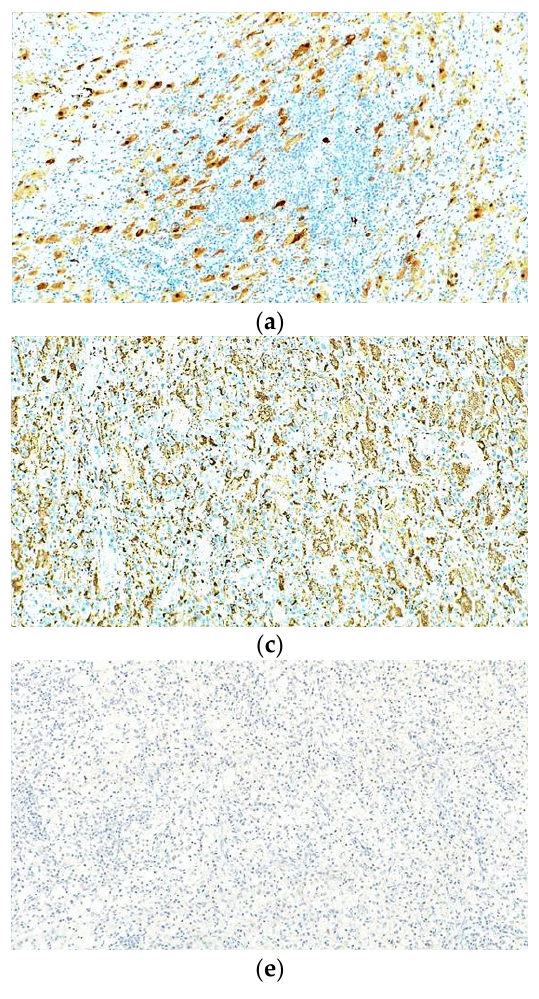
Figure 9. Rosai – Dorfman disease of the bone. Immunohistochemical positive reactions for ( a ) S100; ( b ) CD68; ( c ) CD163; ( d ) Cyclin D1; ( e ) negative for CD1a; in the lesional histiocytes. IHC staining with DAB chromogen, 100×.